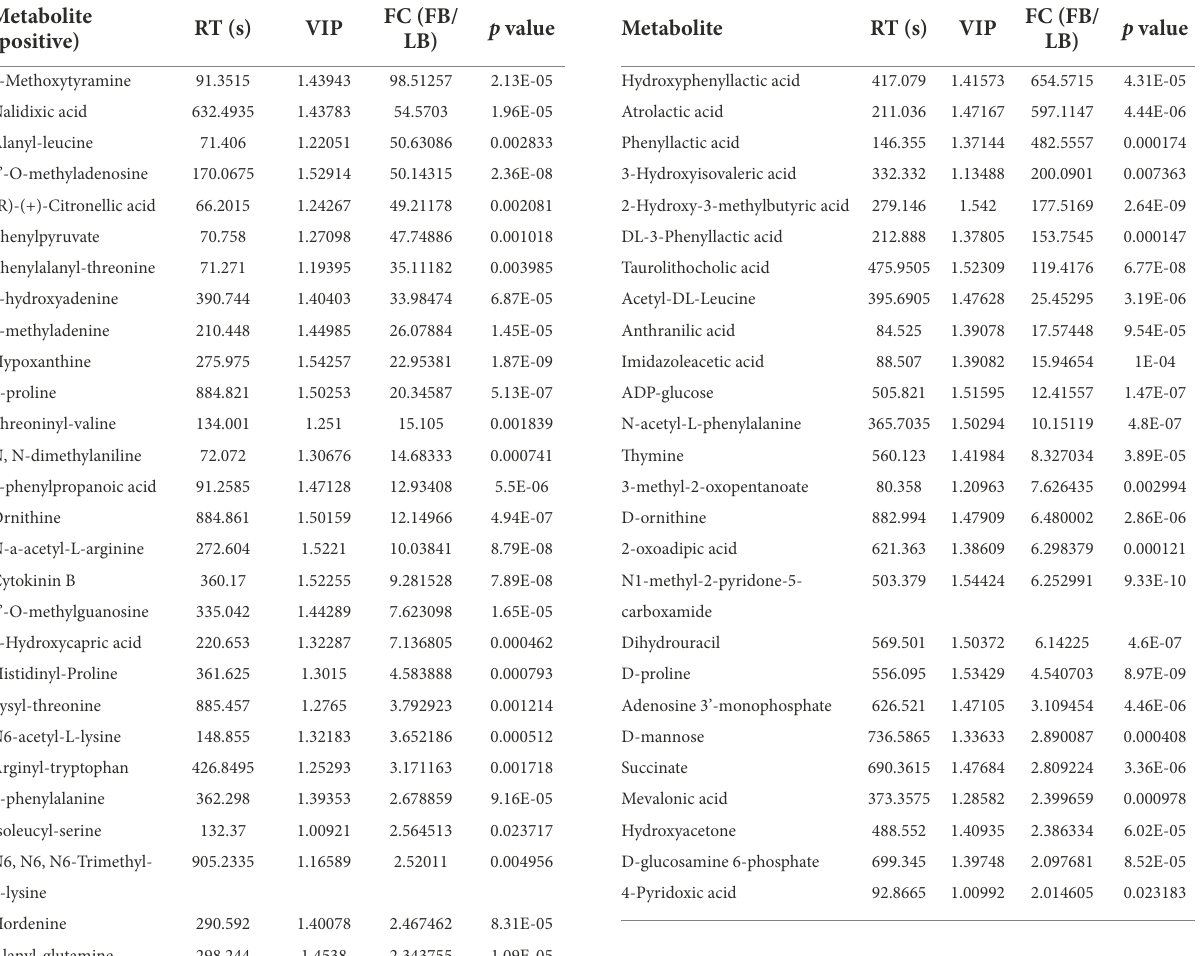
TABLE 1 The differential metabolites identified in positive modes. TABLE 2 The differential metabolites identified in negative